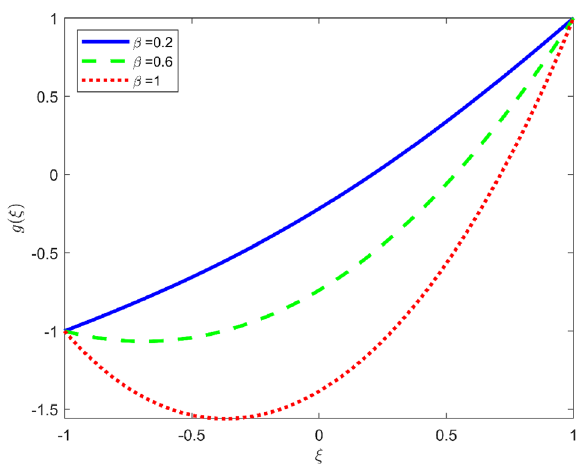
1, Ha 1, φ 1 0.02 , φ 2 φ 3 = = = = =